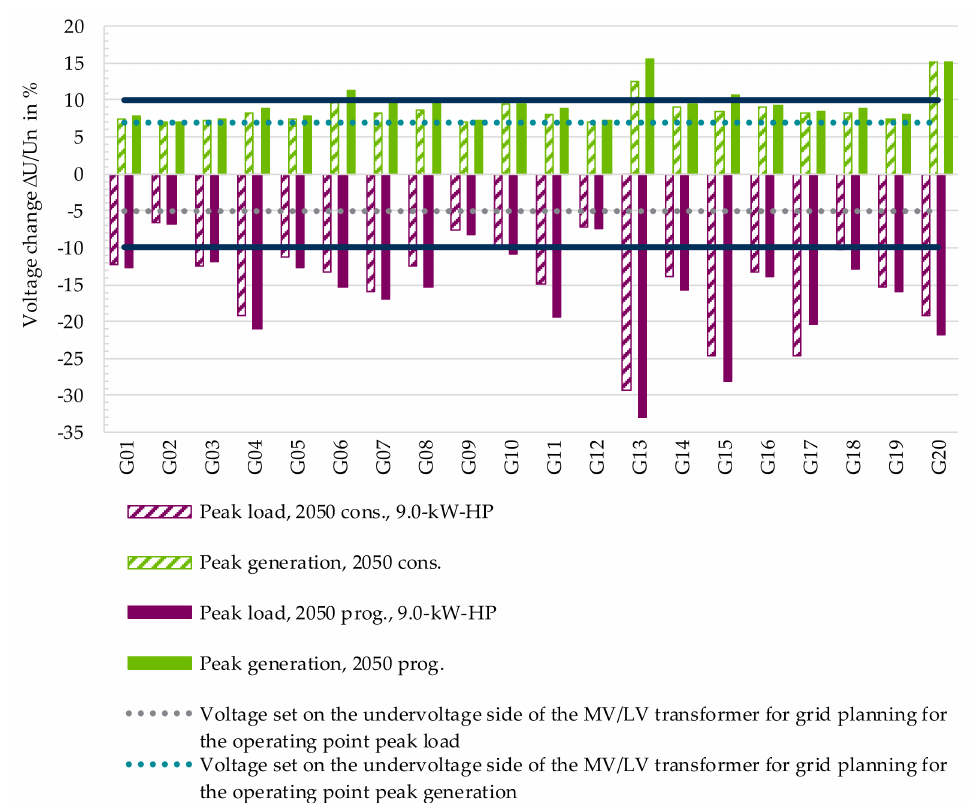
Figure 29. Maximum voltage change for the operating points “peak generation” and “peak load” for 20 low-voltage grids at the year 2050 in the progressive scenario with 9.0 kW heat pumps for the conservative (cons.) and progressive (prog.)